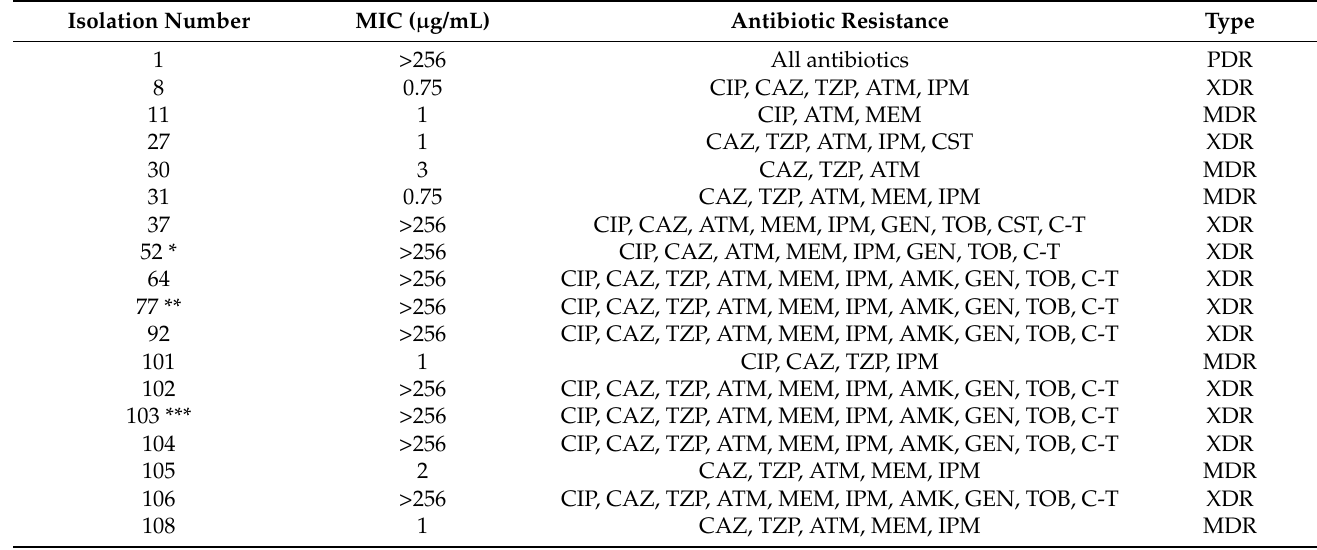
Table 3. The characteristics of the 18 resistant PA isolates and the MIC of ceftolozane-tazobactam for each isolate. * Isolate with bla IMP , ** Isolate with bla NDM and *** Isolate with bla VIM .